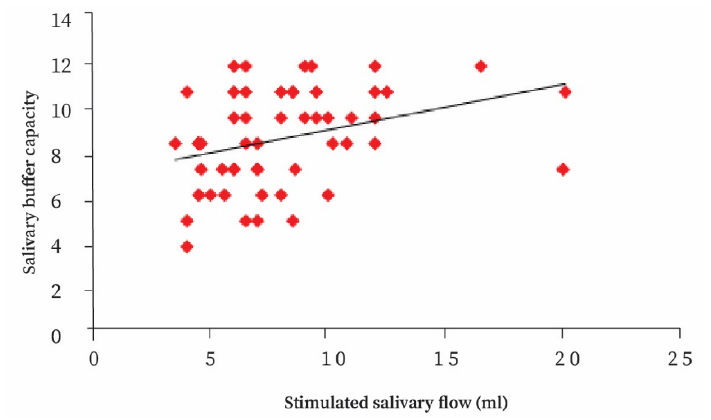
Figure 3. Dependence of salivary buffer capacity on the stimulated salivary flow (ml).